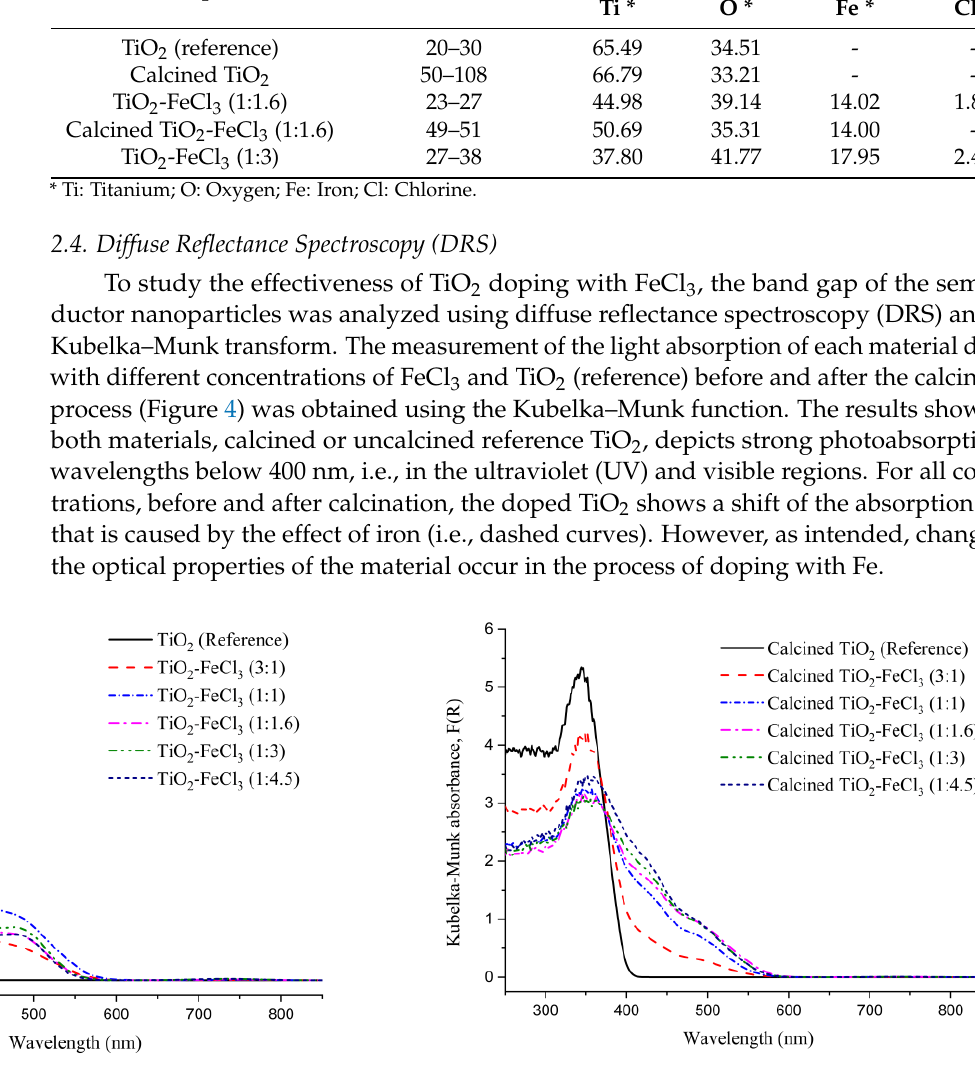
Table 2. Particle size variation and characterization of each sample studied.